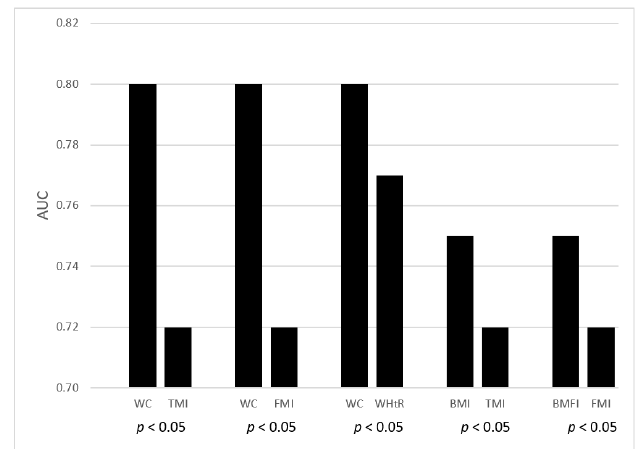
Figure 1. Area under curve (AUC) pairwise comparison of the different indexes of adiposity/body composition among females (only significant results are reported).